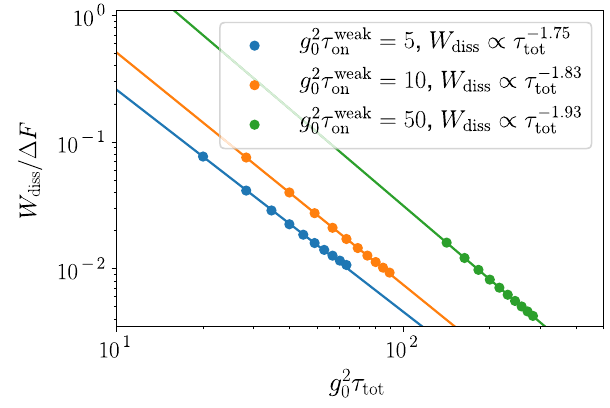
FIG. 9. Dissipated work W model for various switching times and values of k . As a function of k , the isotherm time is reduced as τ switch-on and switch-off times are increased either as τ k τ weak (dashed lines) or τ on ε